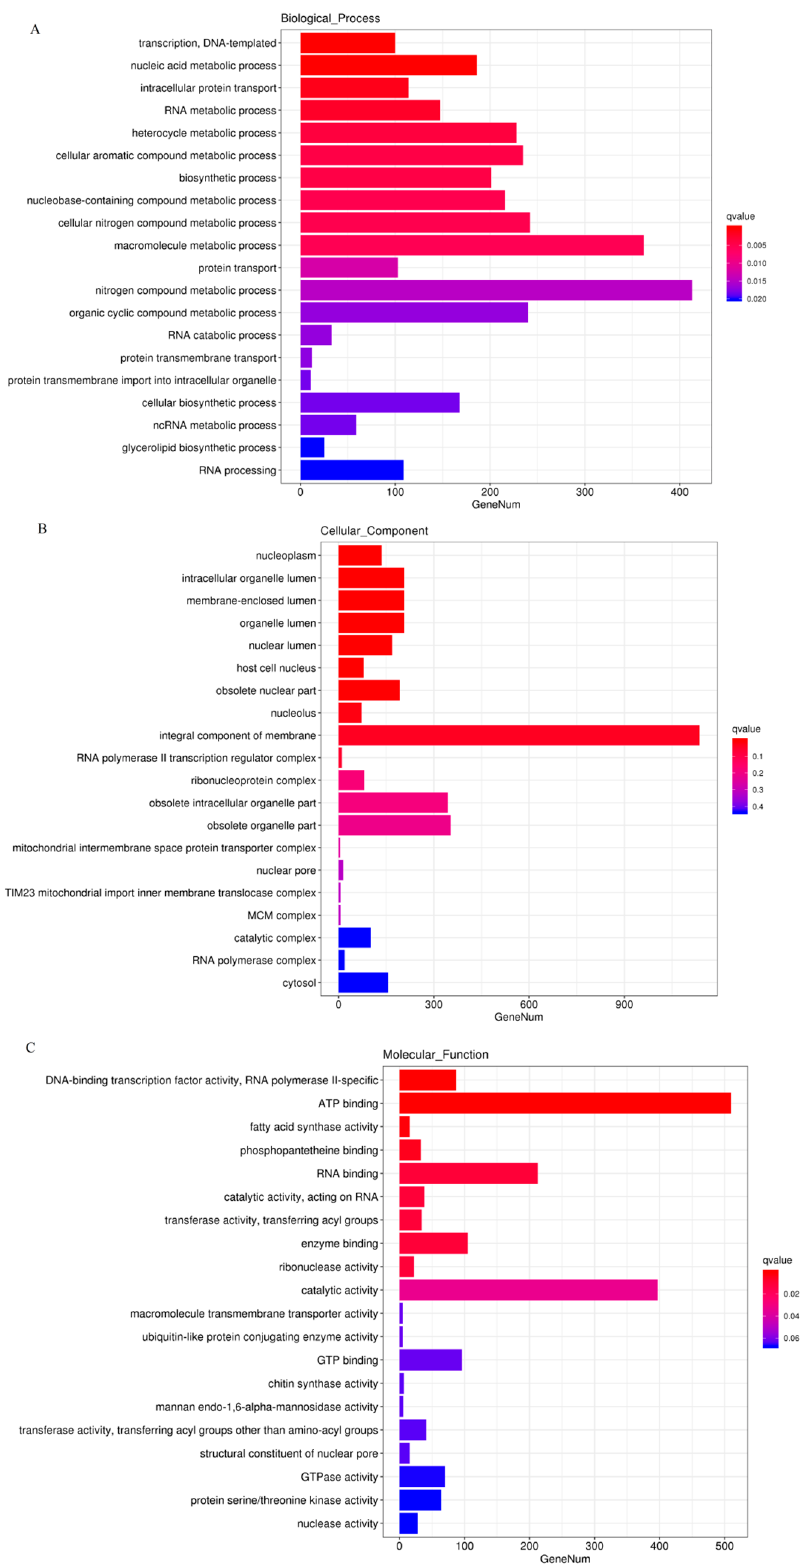
Figure 3. The most enriched GO functional classification of DEGs in IL vs. L. The most enriched GO terms in Biological_Process ( A ), Cellular_Component ( B ) and Molecular_Function ( C ) were presented. X -axis represents the gene number of top GO terms enriched among DEGs. L represents the pre-infected larva of H. xiaojinensis. IL represents the one-year post-infection larva of H. xiaojinensis by O. sinensis .